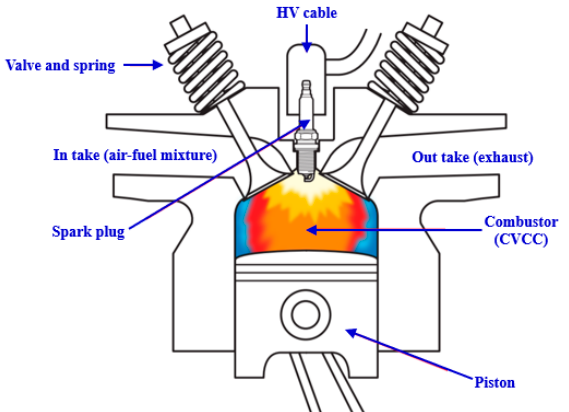
Figure 2. Spark plug location in a constant volume combustion chamber.